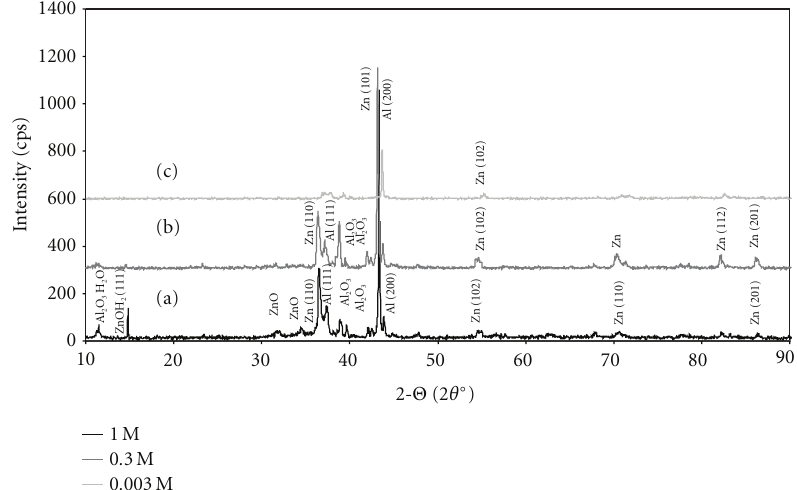
Figure 9: X-Ray di ff raction pattern of the Zn-10Al-1.5Cu alloy at T = 25 ◦ C and (a) 1 M NaCl, (b) 0.3M NaCl, (c) 0.003M